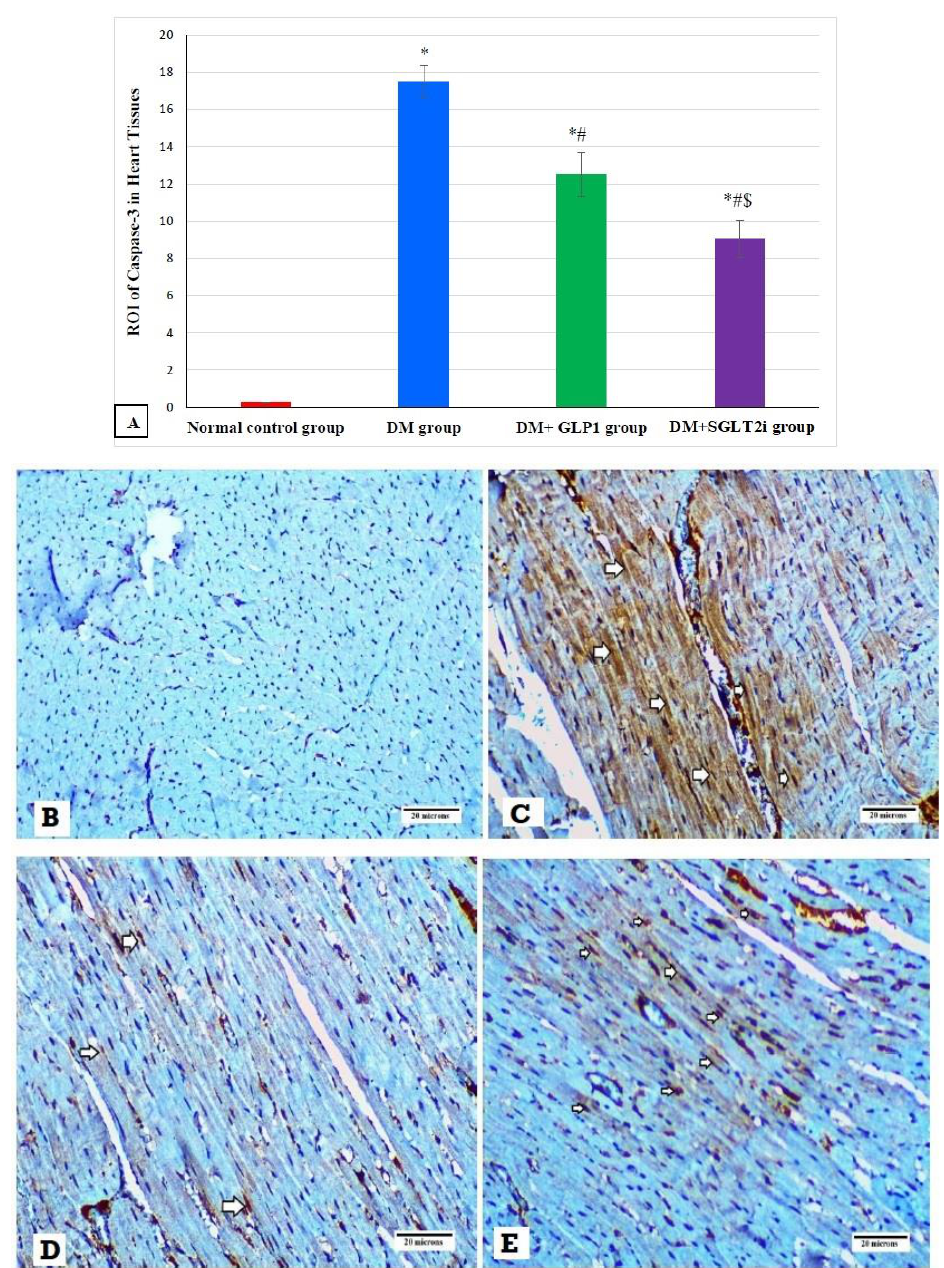
Figure 6. The expression of caspase-3 by immunostaining in different groups. ( A ) Graphs of ROI of the expression of caspase-3 in different groups. Heart specimens showing ( B ) negative cytoplasmic expression of caspase-3 in cardiomyocytes (control group), ( C ) marked cytoplasmic expression of caspase-3 in cardiomyocytes (arrows) (DM group), ( D ) moderate cytoplasmic expression of caspase-3 in cardiomyocytes (arrows) (DM+ GLP1 group), and ( E ) minimal cytoplasmic expression of caspase-3 in cardiomyocytes (arrows) (DM+ SGLT2i group). * Significant vs control group, # significant vs DM group, and $ significant vs DM+ GLP1 group.